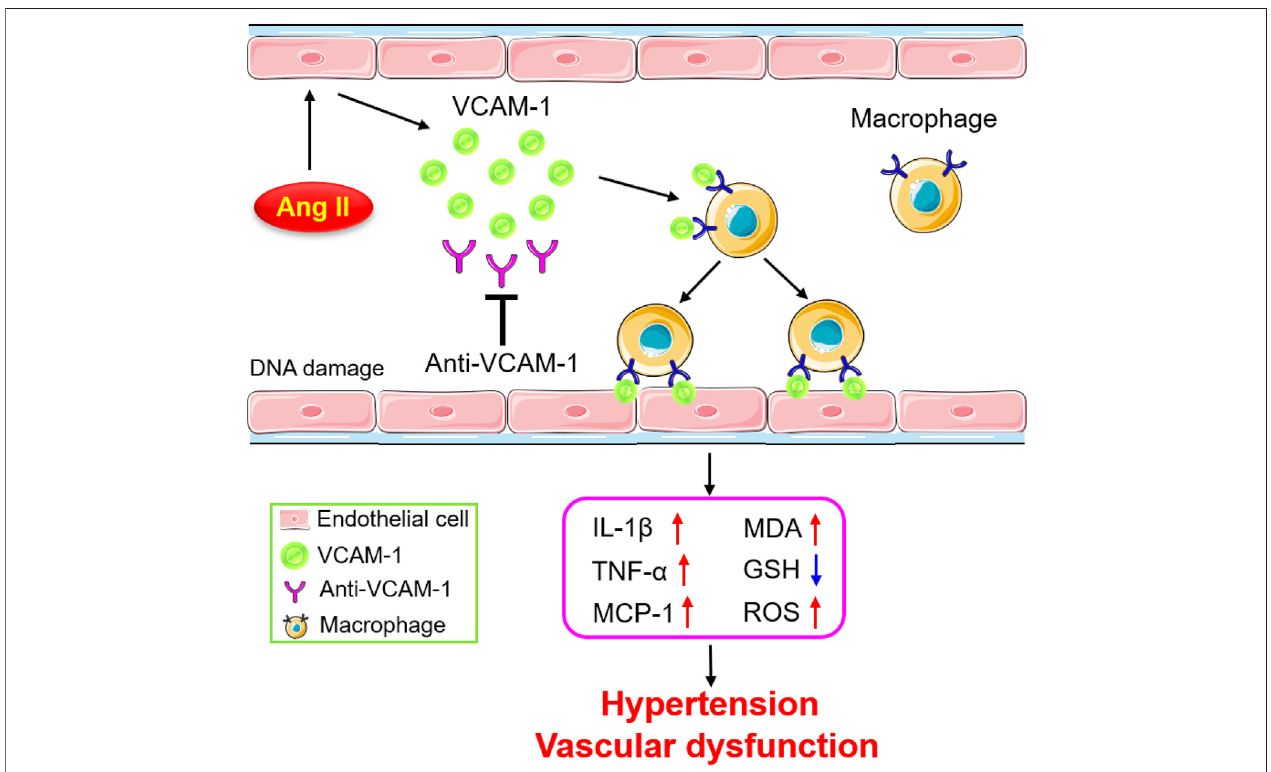
FIGURE 7 | Schematic diagram of the mechanism by which VCAM-1-mediated macrophage adhesion and migration alleviate Ang II-induced hypertension and vascular remodeling. Ang IIstimulatesvascular ECs torelease VCAM-1, whichpromotes theadhesion ofmacrophages tothe arterial endothelium and their subsequent transmigration into the vascular wall. Activated macrophages secrete abundant cytokines and ROS, leading to vascular dysfunction and hypertension. In contrast, blockade of VCAM-1 signi fi cantly inhibits these